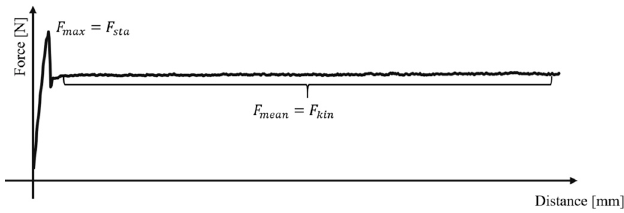
Figure 4. A chart showing the relationship of force of friction to